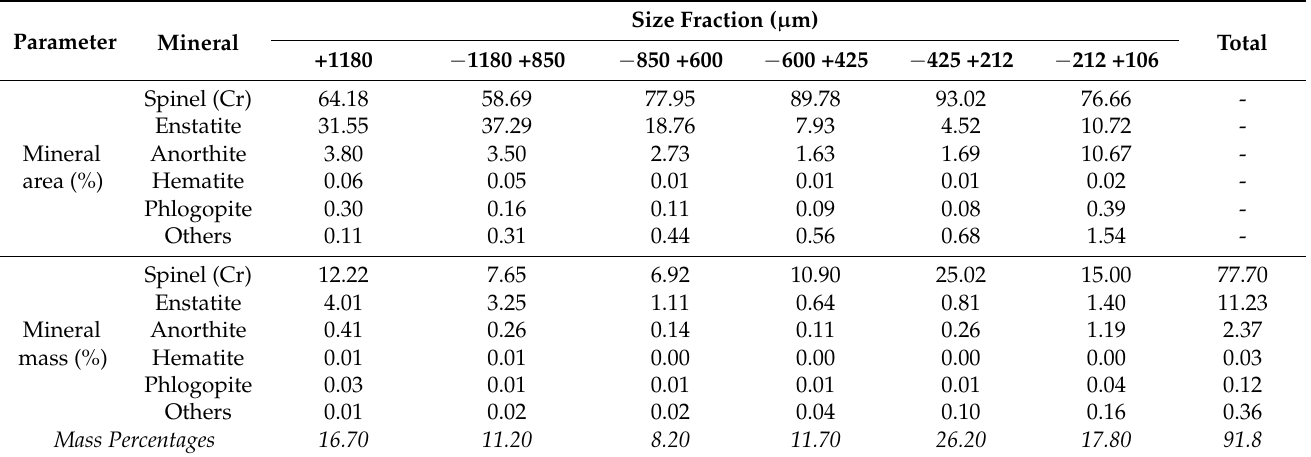
Table 5. Modal mineralogy determined by QEMSCAN